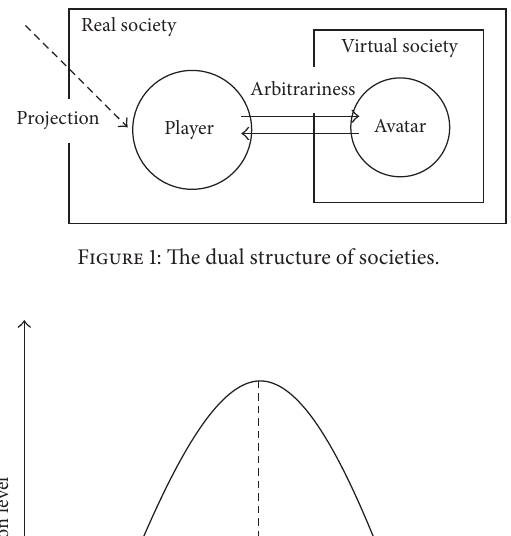
autocrat acquired sovereignty by transfers created in the society that restricts the objective freedom of